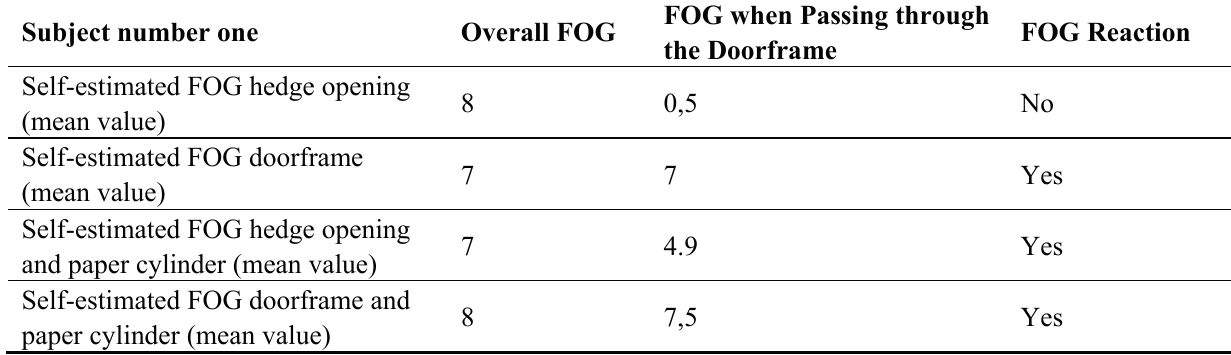
Table 4. Self-estimated FOG and observable FOG reaction in test round with the subject with the strongest FOG reaction in